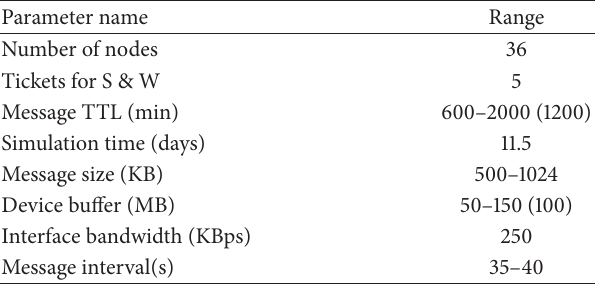
Table 4: Simulation settings of Cambridge-iMote